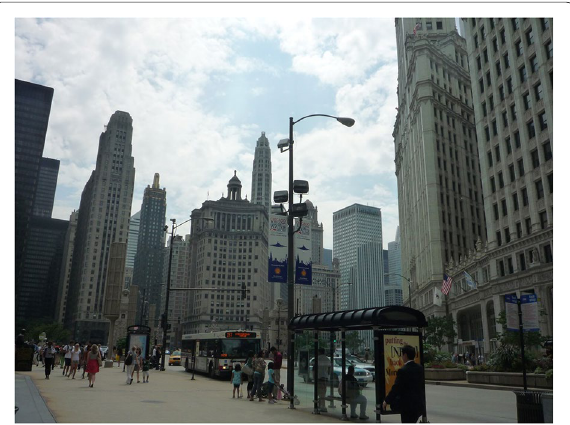
Fig. 16 Chicago’s oldest buildings represent solid